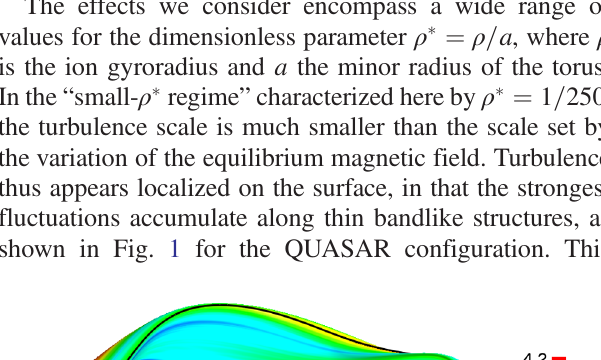
ffiffiffiffiffiffiffiffiffiffiffiffi p T =m is the ion i i